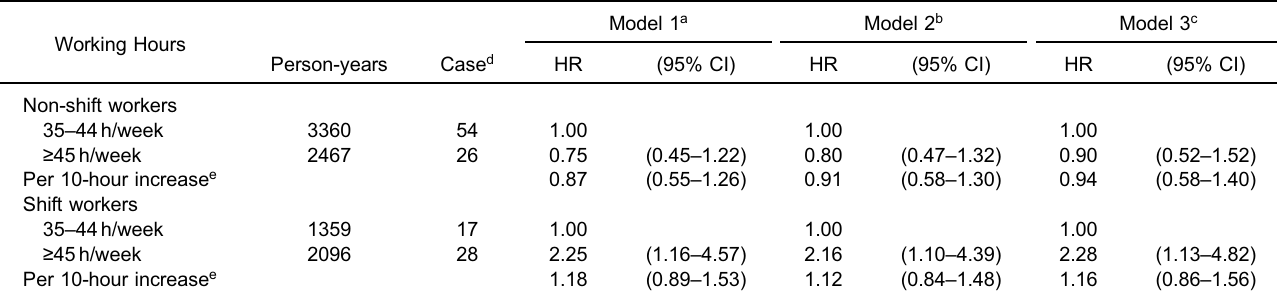
Table 3. Hazard ratios for the incidence of diabetes associated with long working hours by shift work schedules among non- clerical workers (non-shift workers n = 1347, shift workers n = 777) Working